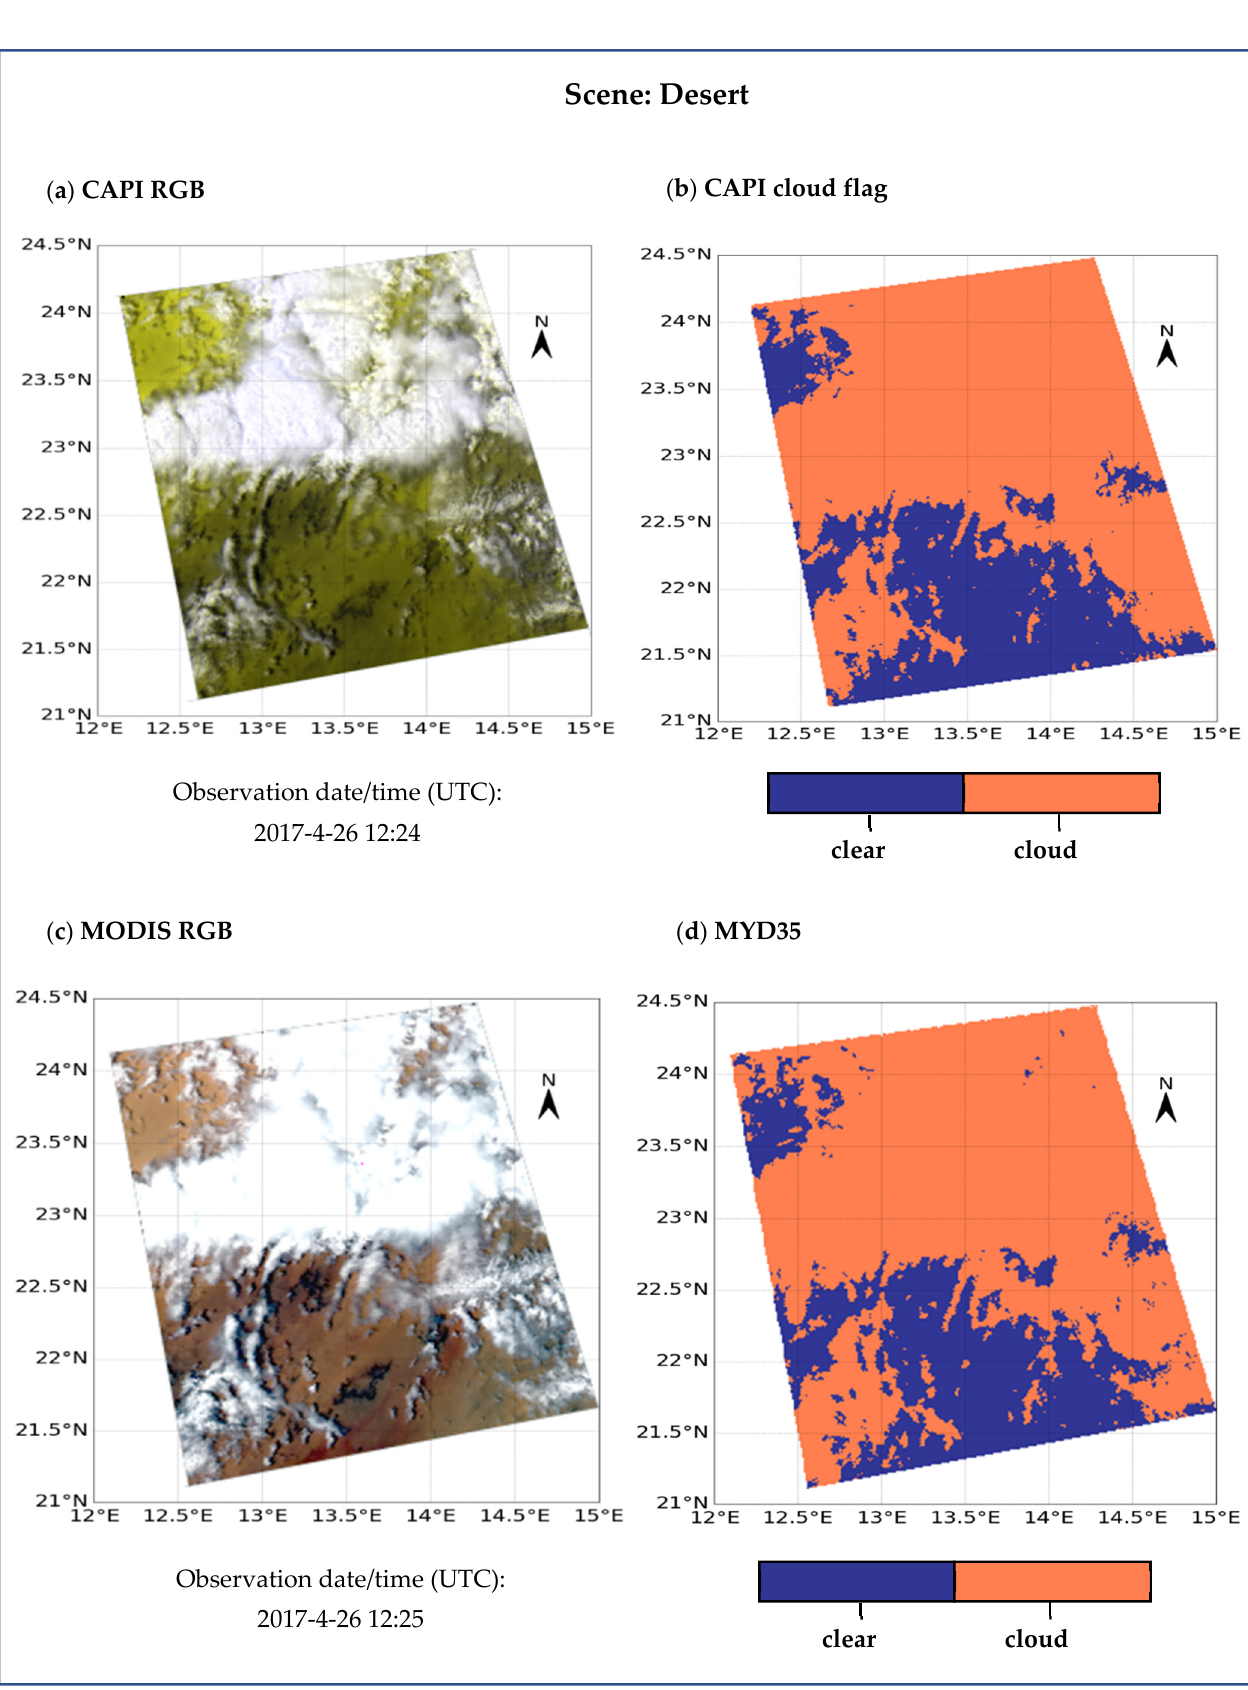
Figure 7. Same as Figure 4, but over the Sahara Desert at 12:24 UTC 26 April 2017 for CAPI and at 12:25 UTC 26 April 2017 for MODIS.